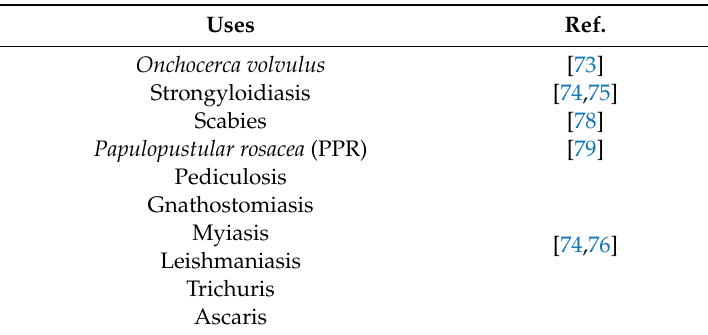
Table 2. Summary of human uses of